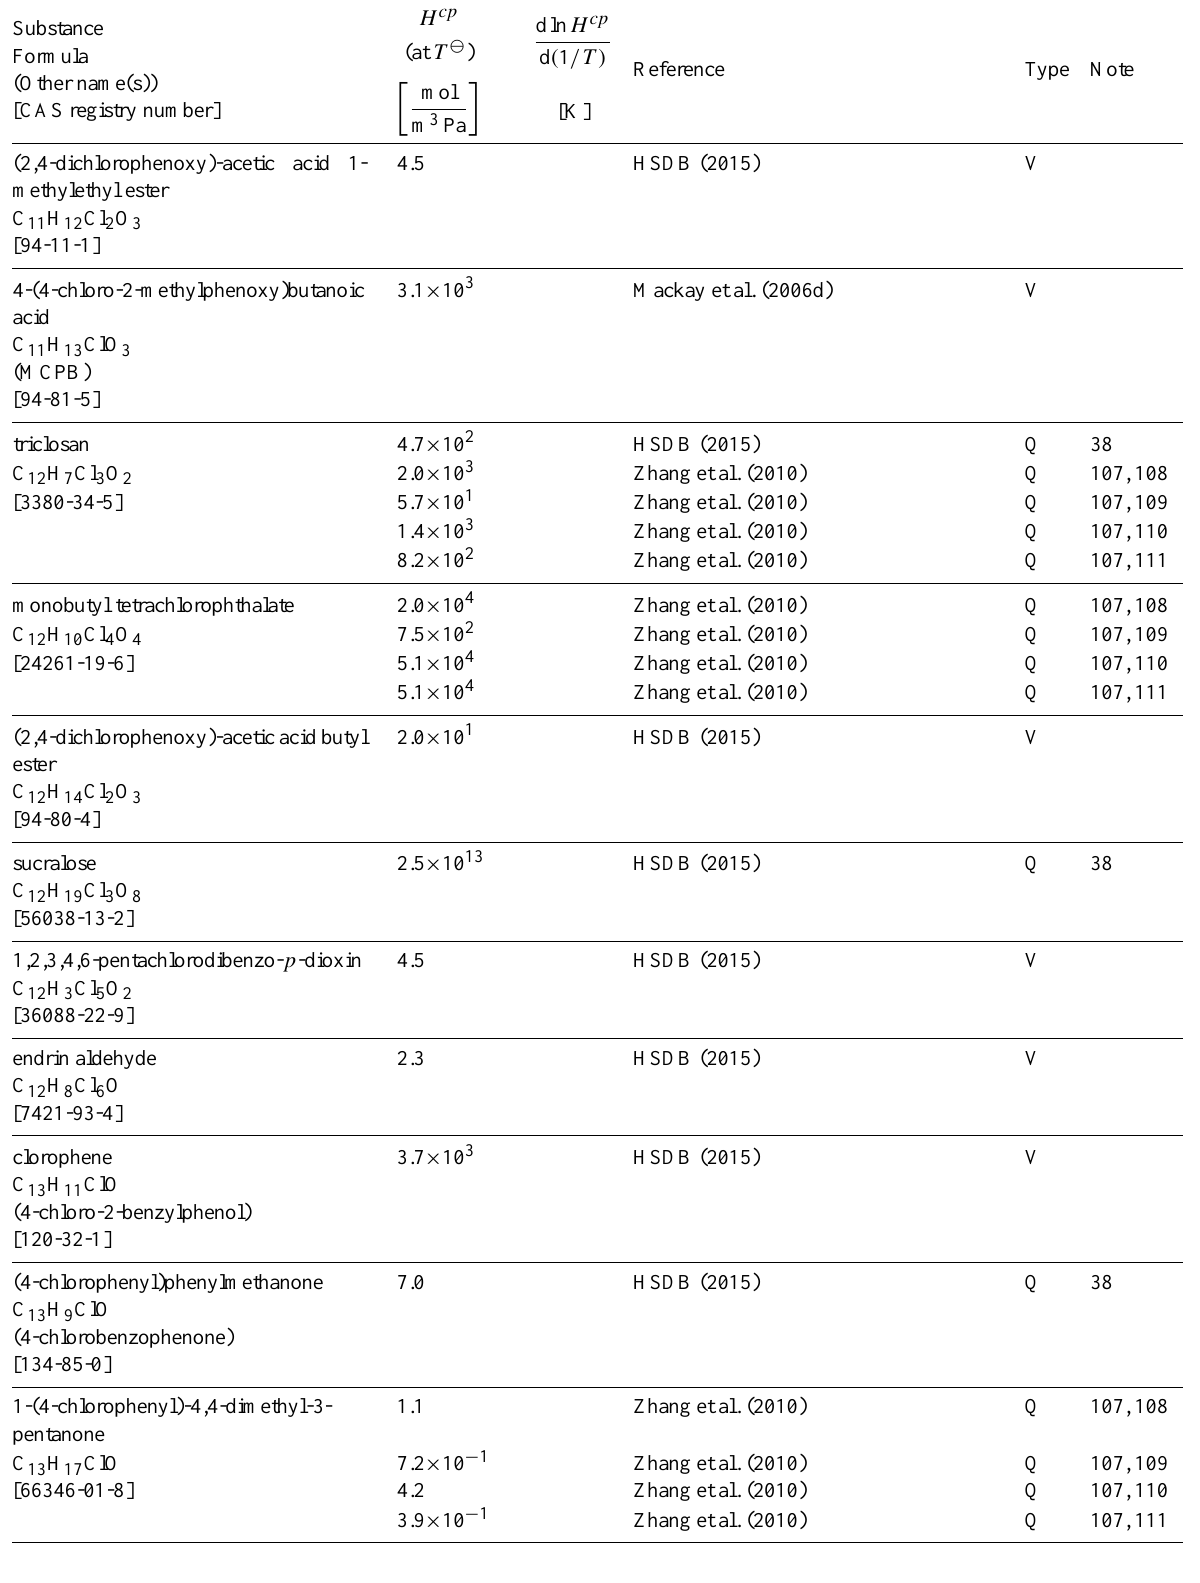
Table 6: Henry’s law constants for water as solvent